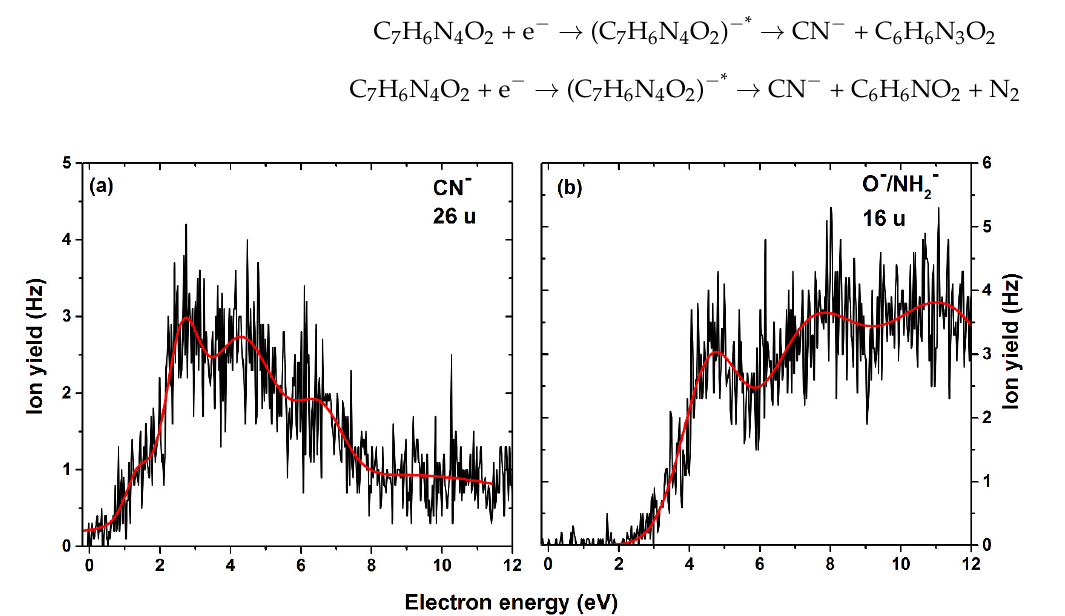
− and ( b ) O − /NH − upon electron attachment to 2